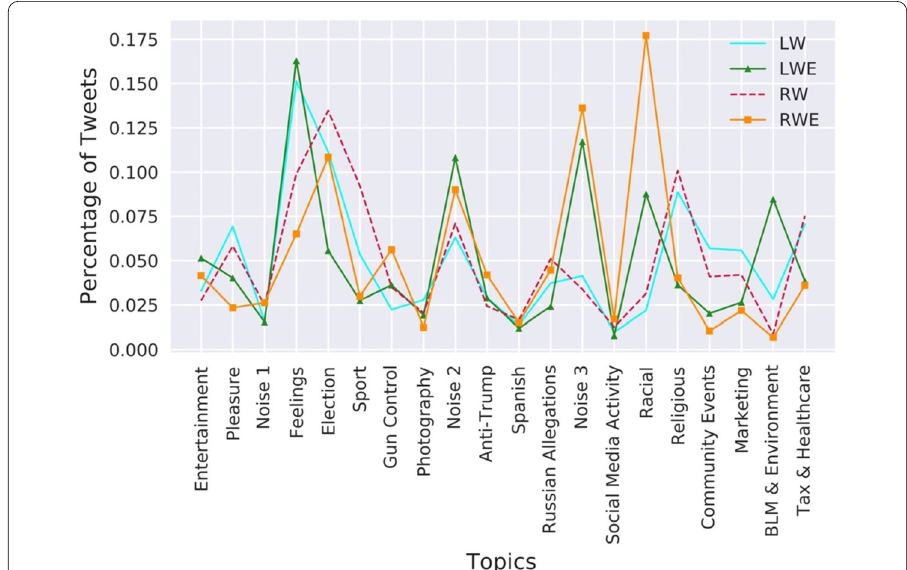
Figure 1 Distribution of Twitter-LDA-generated topics across various political groups. The number of topics is set to 20. While the frequency of occurrence of some topics are similar among the groups (e.g. entertainment and photography), there are topics that their frequency differences between groups are high (e.g. sport and racial). We control for a topic if it is semantically meaningful (i.e. it is not a noisy outcome of the LDA) and does not overlap too much with the word categories of interest in LIWC and MFD. As a result, we remove Noise 1, 2, & 3, Feelings, and Pleasure topics and controlled for the remaining 15